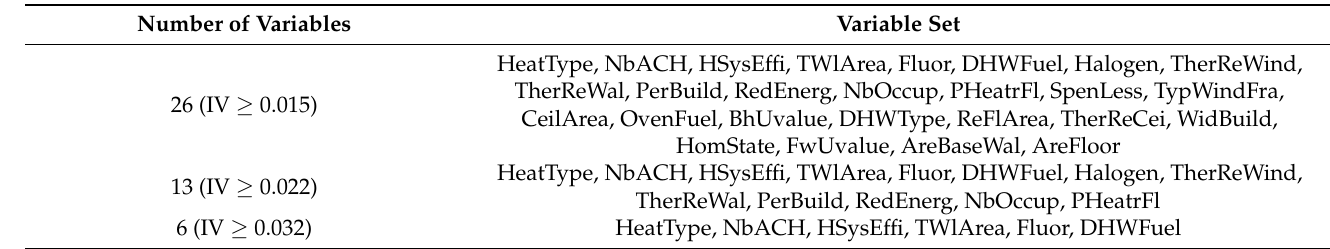
Table 3. Variable selected for predicting natural gas